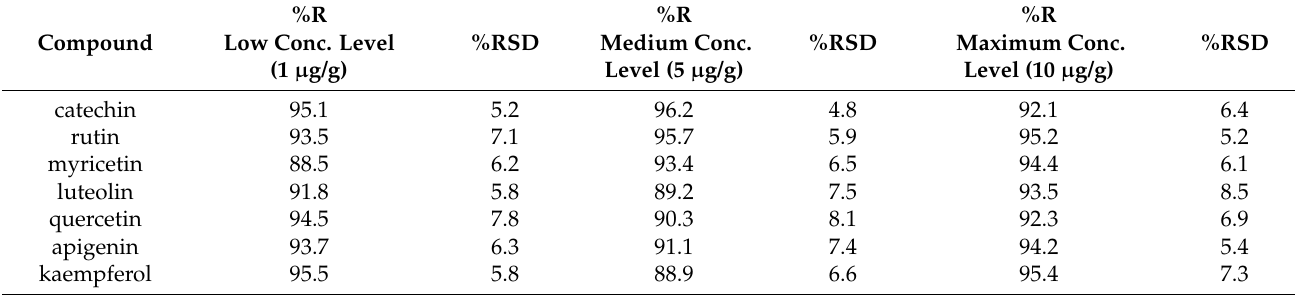
Table 3. %Recoveries (%R, n = 3 × 3) for the evaluation of intermediate